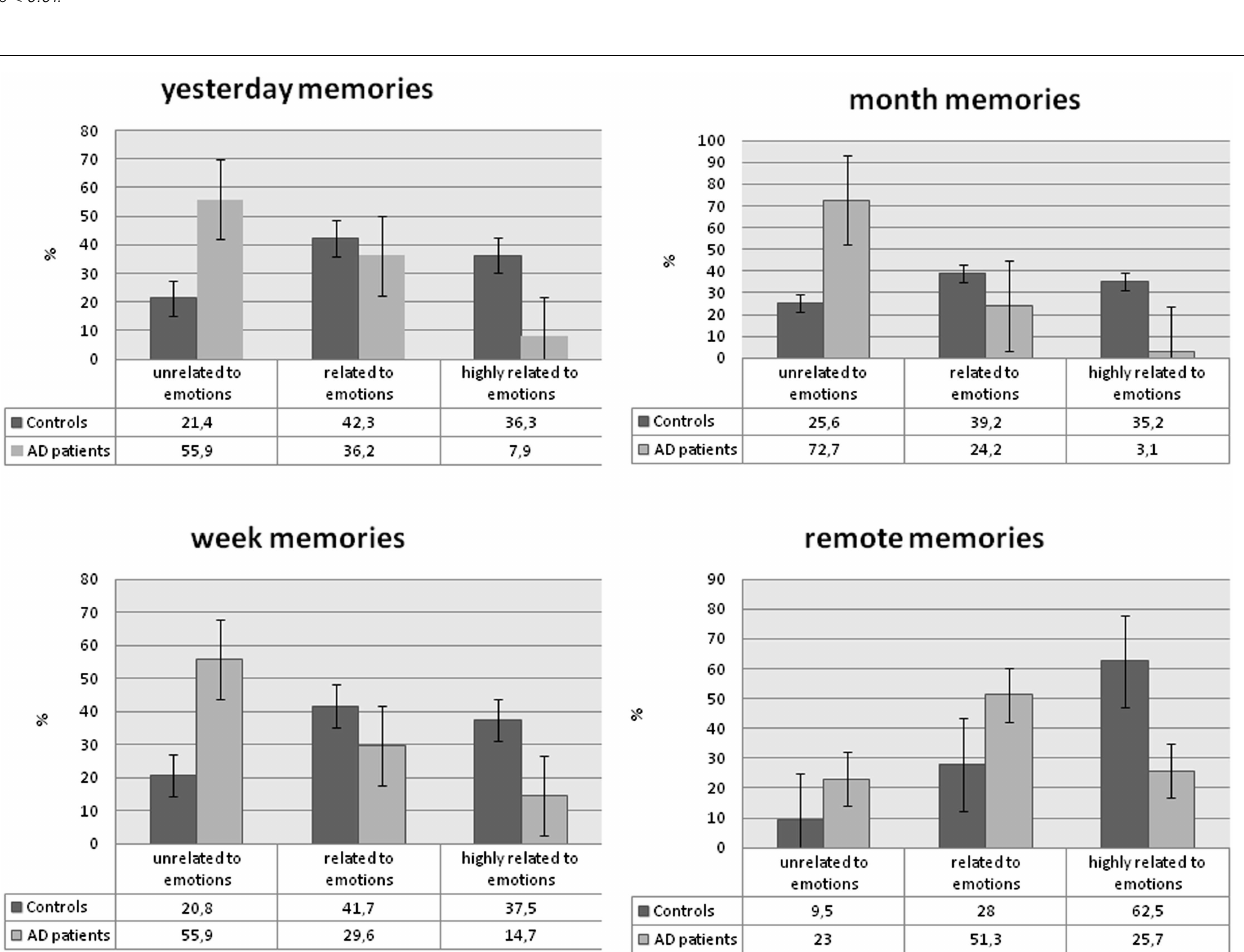
FIGURE 1 | Distribution of the percentages of the scores given in each memory category . Comment: emotional expression of subject’s voice on 0–2 rating scale: 0 – unrelated to emotion, 1 – related, 2 – highly related.